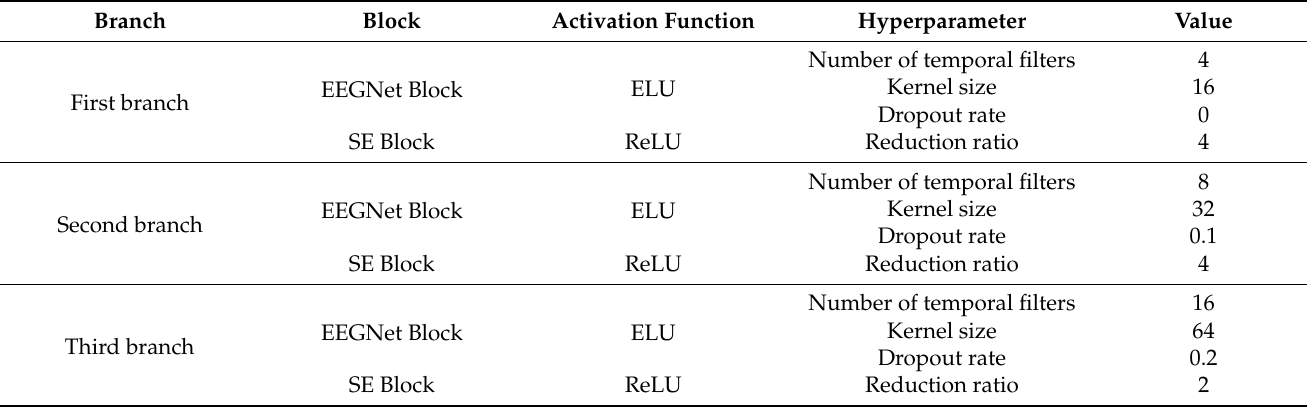
Table 1. Global hyper-parameters used in proposed